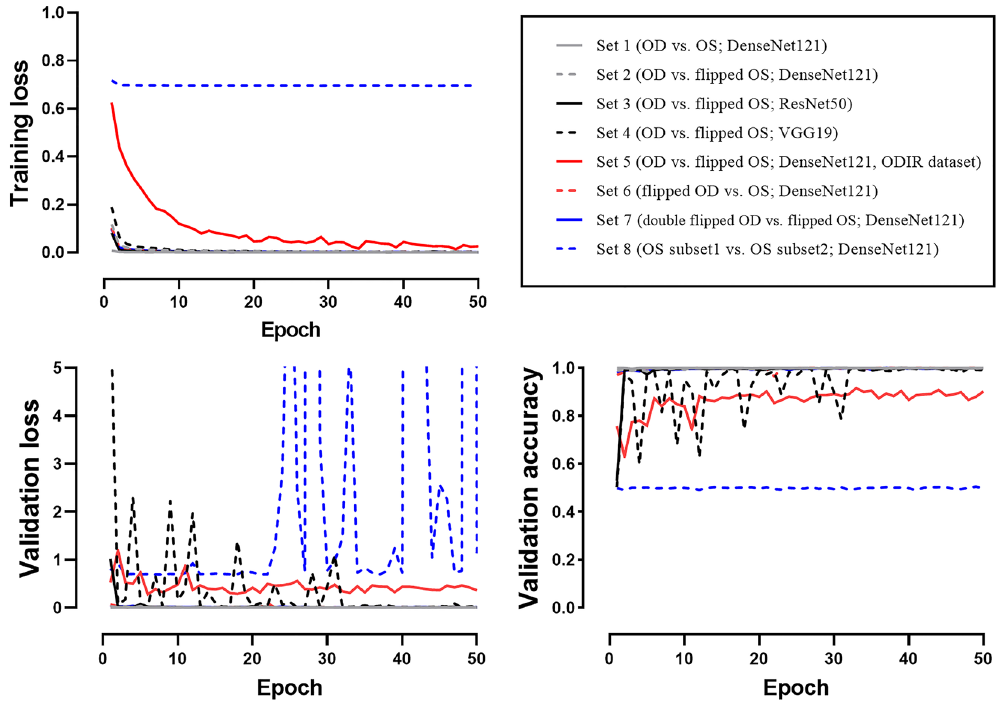
Figure 1. Training and validation plot. The training and validation losses approached zero for Sets 1–7, while the losses of Set 8 were divergent. The validation accuracy of Sets 1–7 improved, to approach 1.0, while the validation accuracy of Set 8 remained at 0.5 and did not improve (dashed blue line). DenseNet121 showed lower performance in the ODIR dataset (Set 5, solid red line) but tended to improve as the learning process progressed. After 40 epochs, DenseNet121, ResNet50, and VGG19 showed similar excellent performance in Sets